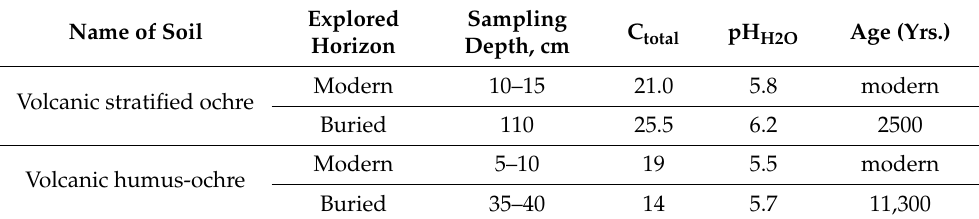
Table 1. Characteristics of the tested